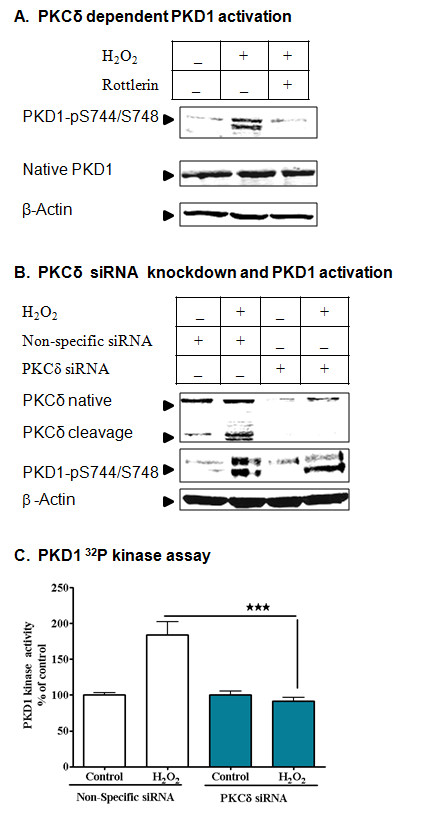
PKCδ dependent phosphorylation of PKD1 activation loop. N27 dopaminergic cells were treated with H2O2 (100 μM) with or without 1 μM rottlerin, and the lysates were probed for PKD1 activation phosphorylation (A). N27 dopaminergic cells were transfected with 1 μM PKCδ siRNA and non-specific siRNA and monitored for PKCδ protein expression and PKD1 activation loop phosphorylation after H2O2 treatment (B) and PKD1 kinase activity assay was performed. **, p < 0.01 denotes significant difference between NS-siRNA-H2O2 and PKCδ-siRNA-H2O2 groups (C).